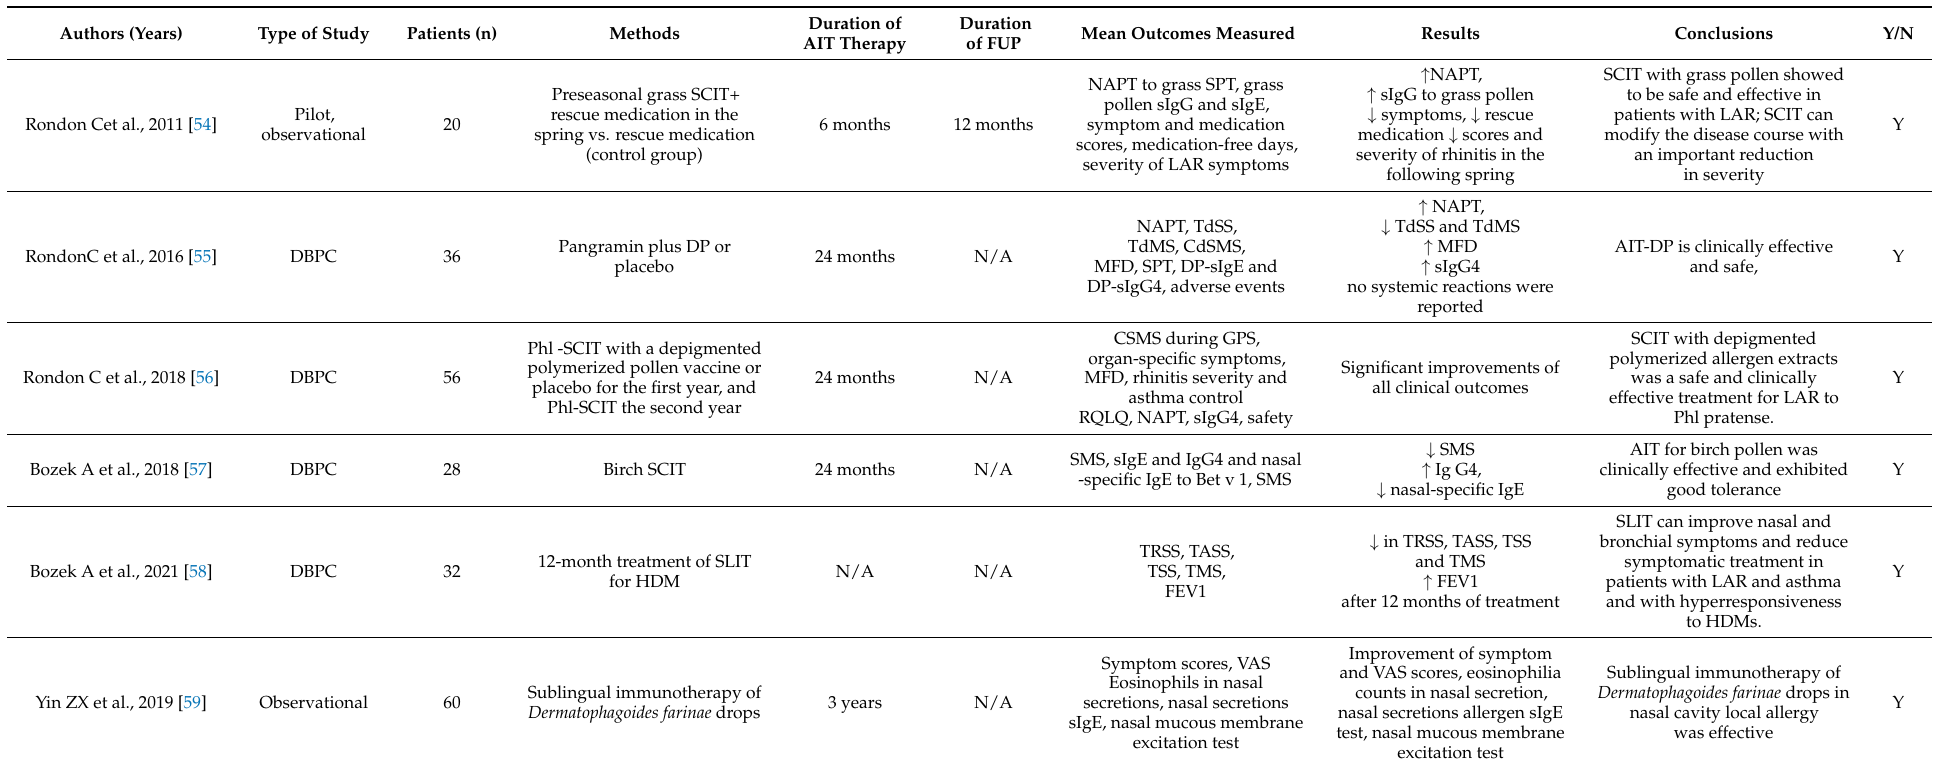
Table 1. Studies on efficacy of AIT in LAR